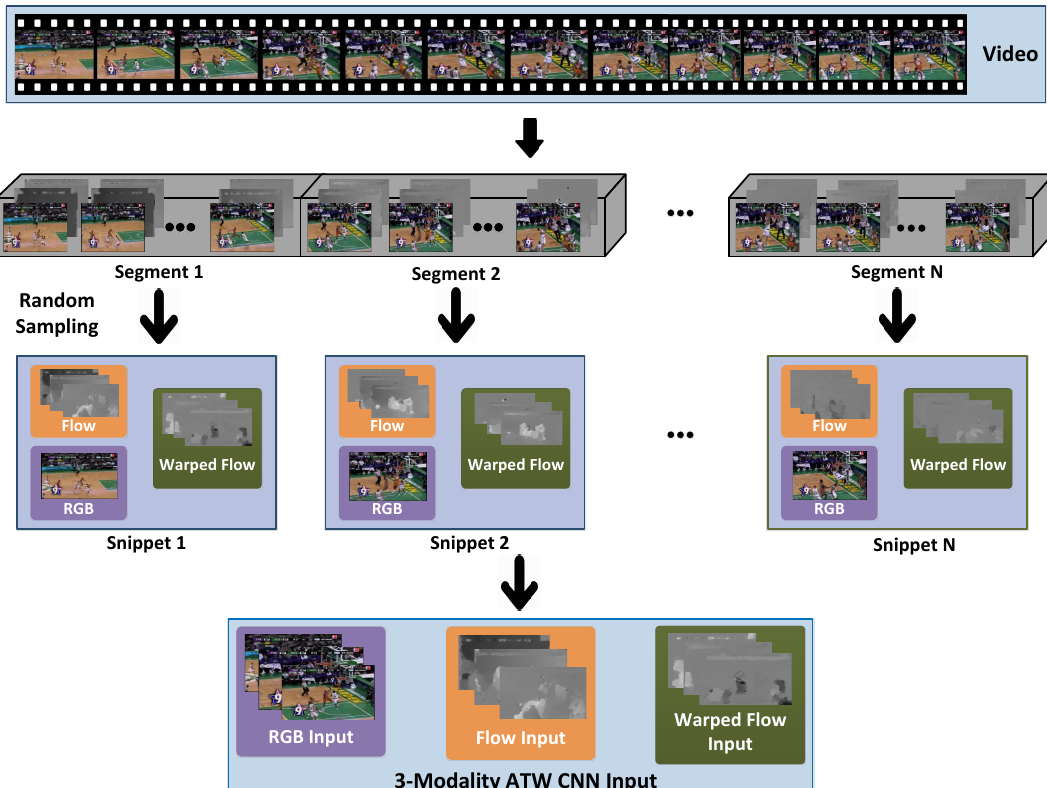
Figure 1. Snippet generation with a fixed target number ( N ) of chunks. A video is evenly portioned into N non-overlapping segments. Each segment contains approximately the same number of video frames. As shown above, two additional modalities derived from RGB video frames are also included, i.e., optical flows and warped optical flows. RGB, optical flow and warped optical flow images sampled from the same segment are grouped in a snippet. We put together the randomly sampled video frames and their corresponding optical flows and warped optical flows respectively as the input of the three stream of the proposed ATW